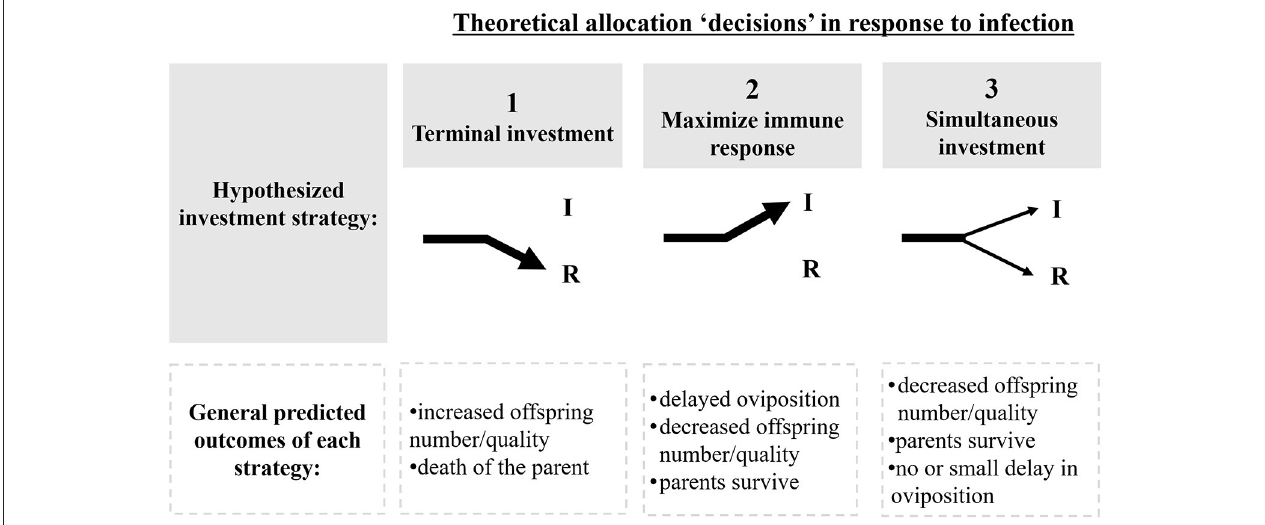
FIGURE 1 | Theoretical allocation strategies in response to pathogens, and their predicted outcomes. Arrows represent the direction in which metabolic energy is diverted to: I, immunity; R, reproduction. Hypothesized investment strategies fall within three theoretical allocation “decisions” in response to infection ( Schwenke et al., 2016; Dani and Kondandaramaiah, 2017; Duffield et al., 2017). The second row describes predicted fitness outcomes resulting from each investment